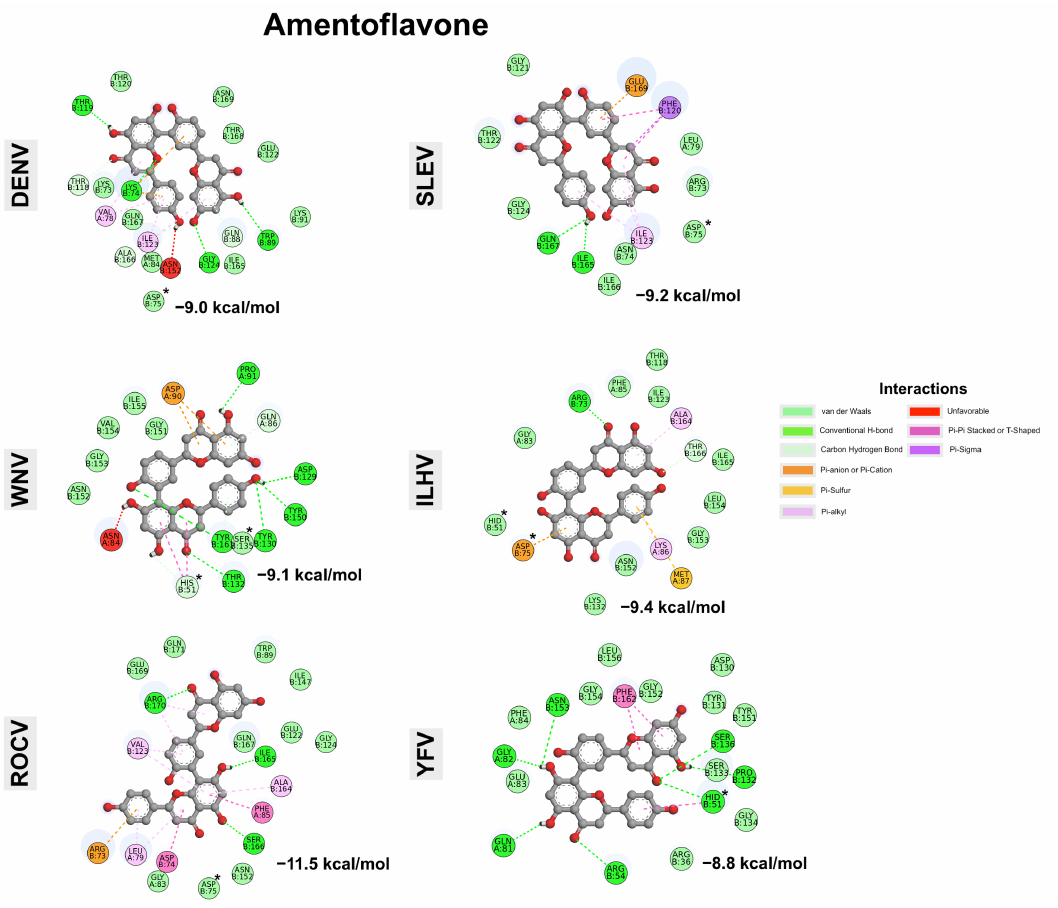
Figure 9. Interaction analysis of the best binding mode of amentoflavone in the NS2B–NS3pro proteins of dengue virus (DENV), West Nile virus (WNV), Rocio virus (ROCV), Saint Louis encephalitis virus (SLEV), Ilhéus virus (ILHV), and yellow fever virus (YFV). The residues from the catalytic triad are marked with *. ILHV NS2B–NS3pro is represented by Cluster 1 only. Cluster 2 is shown in Figure S4. Based on the Vina scores for all the NS2B–NS3pro proteins, the ligands analyzed here showed lower values compared to the docking of chlorcyclizine ( − 5.6 kcal/mol) using the same protein from ZIKV. This compound showed ZIKV-induced cytopathic effects in Vero cells [22]. Our results suggest that quercetin, amentoflavone, and tetrahydrorobustaflavone have the potential to exhibit inhibitory activity against